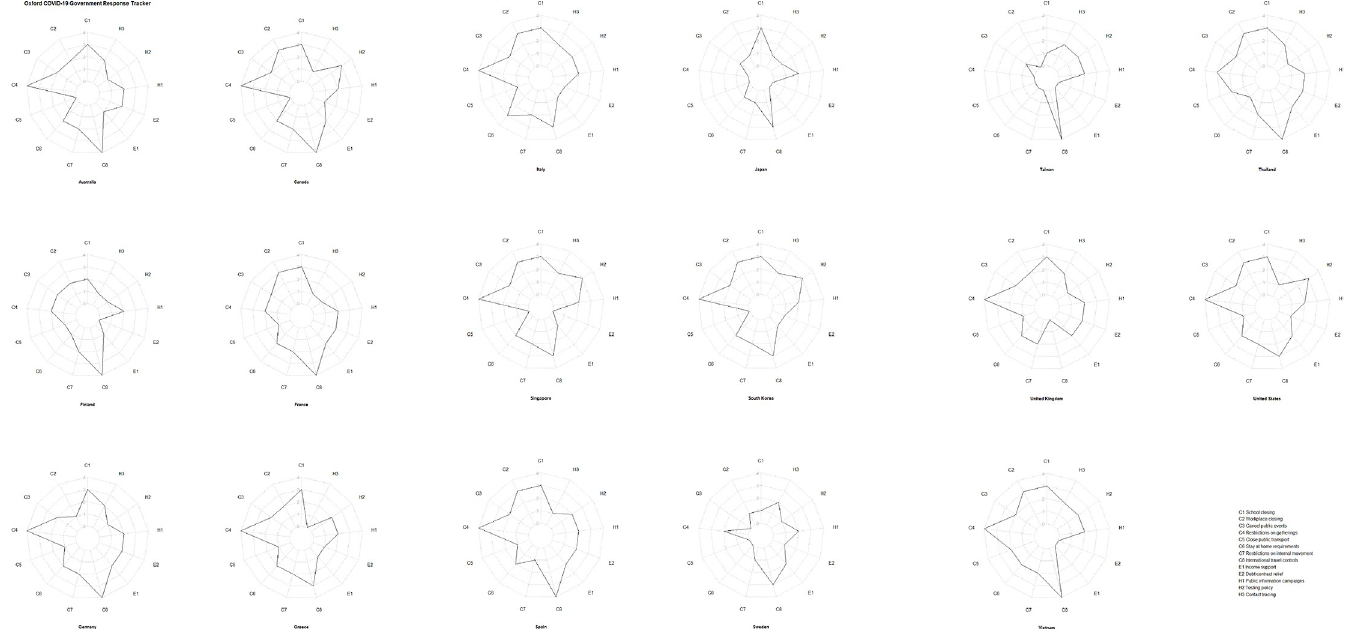
Fig 5. Radar chart of different physical distancing policies with maximum scores in each country.